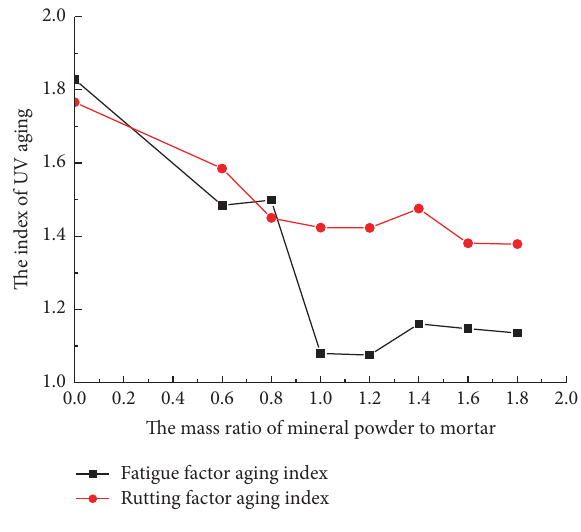
Figure 10: The aging index of base asphalt mortar.